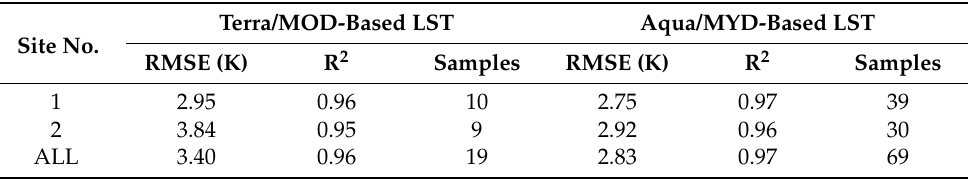
Table 5. Assessment results for the ground sites vs. MODIS MOD and MYD nighttime 30 m LST products from January to October